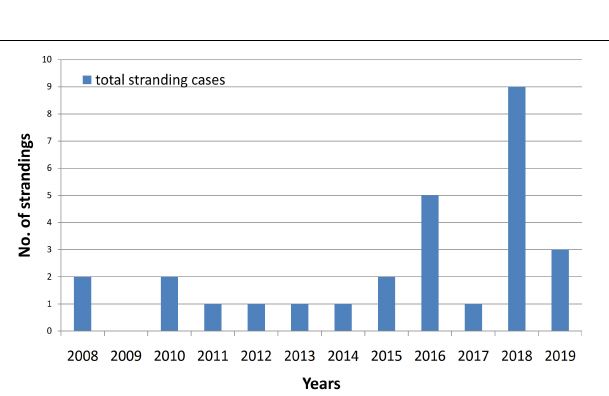
FIGURE 6 | Marine mammal species stranded in Balikpapan Bay 2008–2019 ( n = 29).